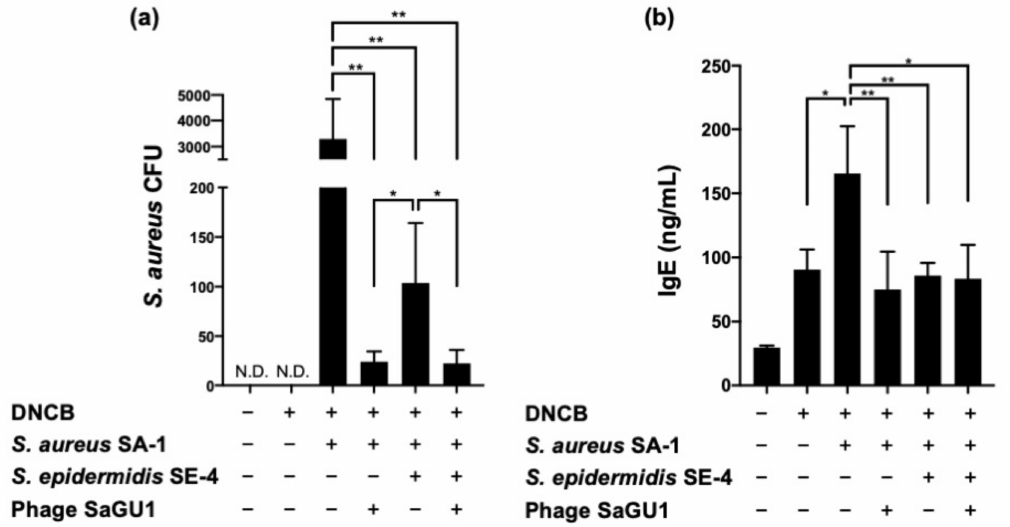
Figure 5. The effect of phage SaGU1 administration in DNCB-challenged mice. ( a ) The number of S. aureus SA-1 was determined by colony counting on LB plates with LVFX. The skin fragments were collected on day 1 after the administration of the treatment. N.D.; not detected. ( b ) The plasma IgE concentration was measured by ELISA. The blood samples were collected on day 3 after the administration of the treatment. The data are presented as the mean ± SD of at least three independent experiments. Student’s t -test was employed to determine a significant difference with or without SaGU1 and/or S. epidermidis SE-4 administration (*, p < 0.05 and **, p <